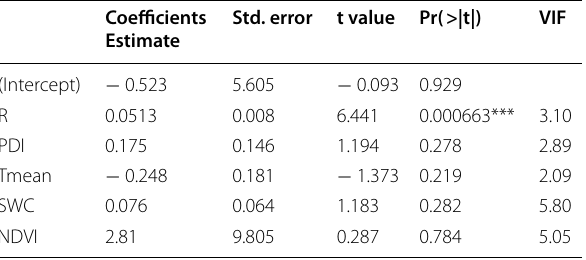
Table 4 Coefficient estimates of the subset regression model